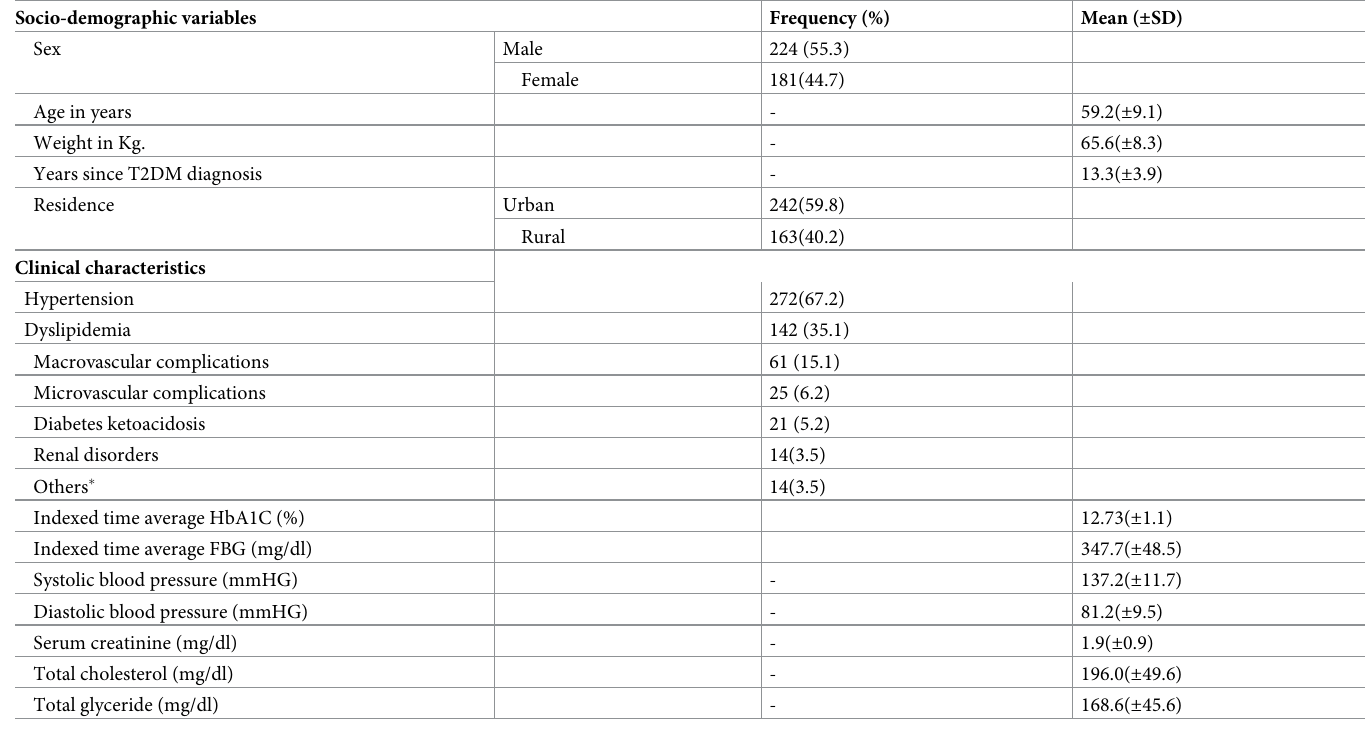
Table 1. Socio-demographic and baseline clinical characteristics of inulin-initiated T2DM patients at UoGCSH from 2015 to 2020 (N =